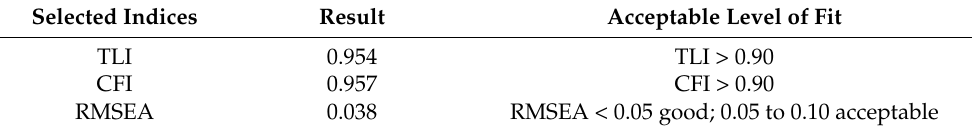
Table 5. Goodness − of − fit